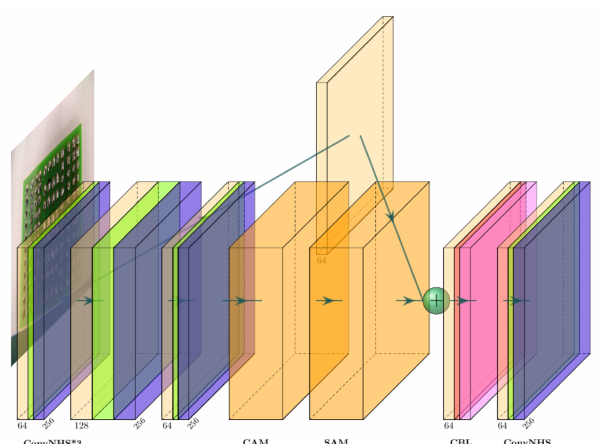
Figure 2. Location feature extraction structure. ConvNHS is a convolution block that contains convolution, normalization, and the Hard Swish activation function. CAM: channel attention mecha- nism. SAM: spatial attention mechanism. CBL, a convolution module, includes convolution, batch normalization, and the LeakyReLU